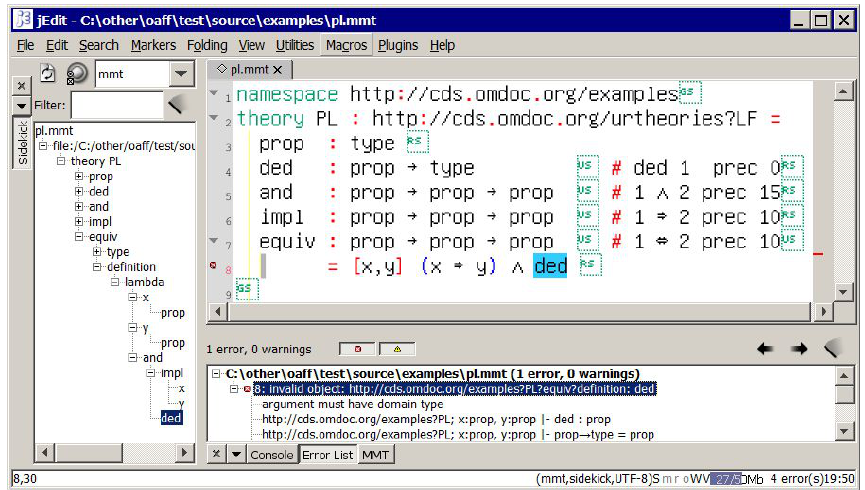
Fig. 3. Mmt IDE based on